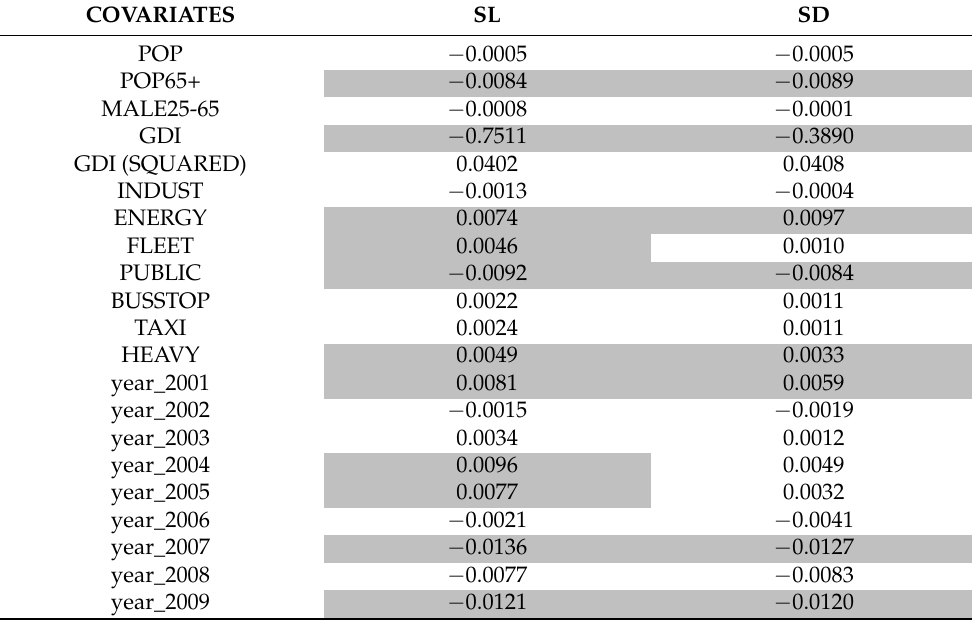
Shaded cells in the indirect impacts indicate significance at the 10% significance level. Direct effects can be obtained by subtracting the indirect effects from the total ones. The level of significance for direct effects is the same as for total effects (Table